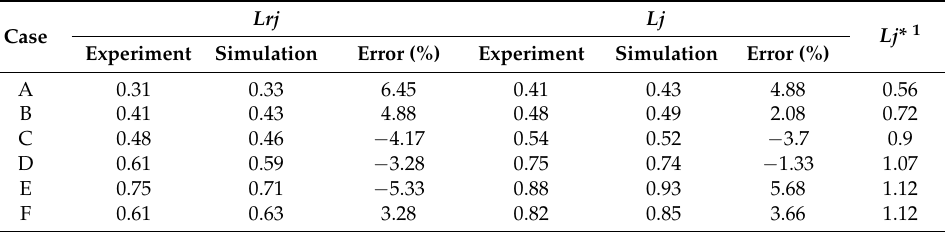
Table 4. Roller lengths and jump lengths of Cases A–F.